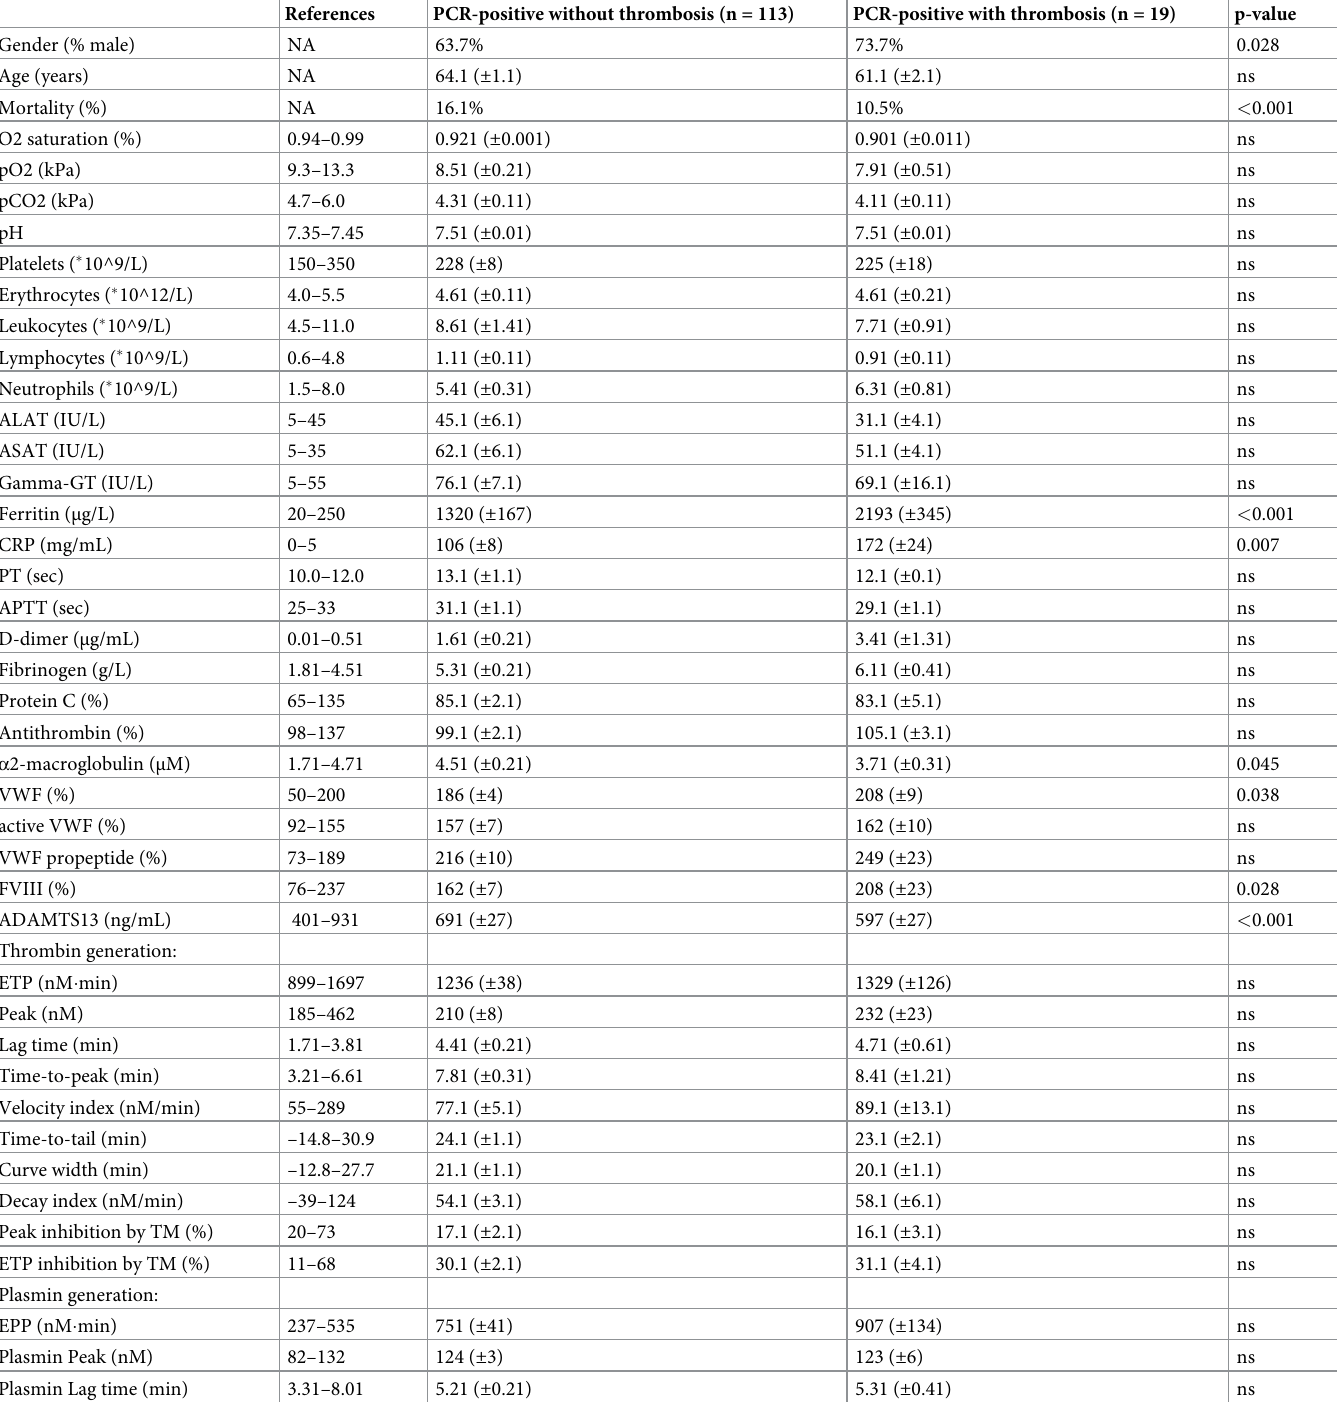
Table 3. General laboratory tests and specific coagulation test in PCR SARS-CoV-2 positive patients with and without